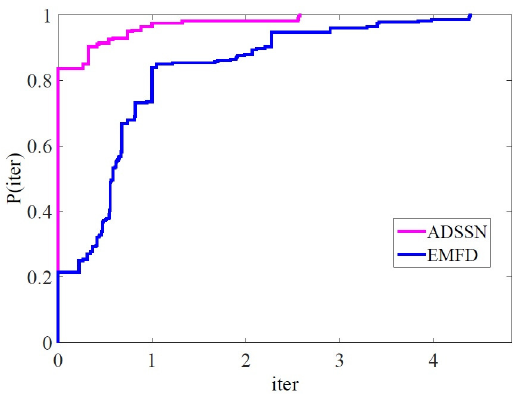
Figure 4. Performance profile of ADSSN versus EMFD [8] with respect to iter .